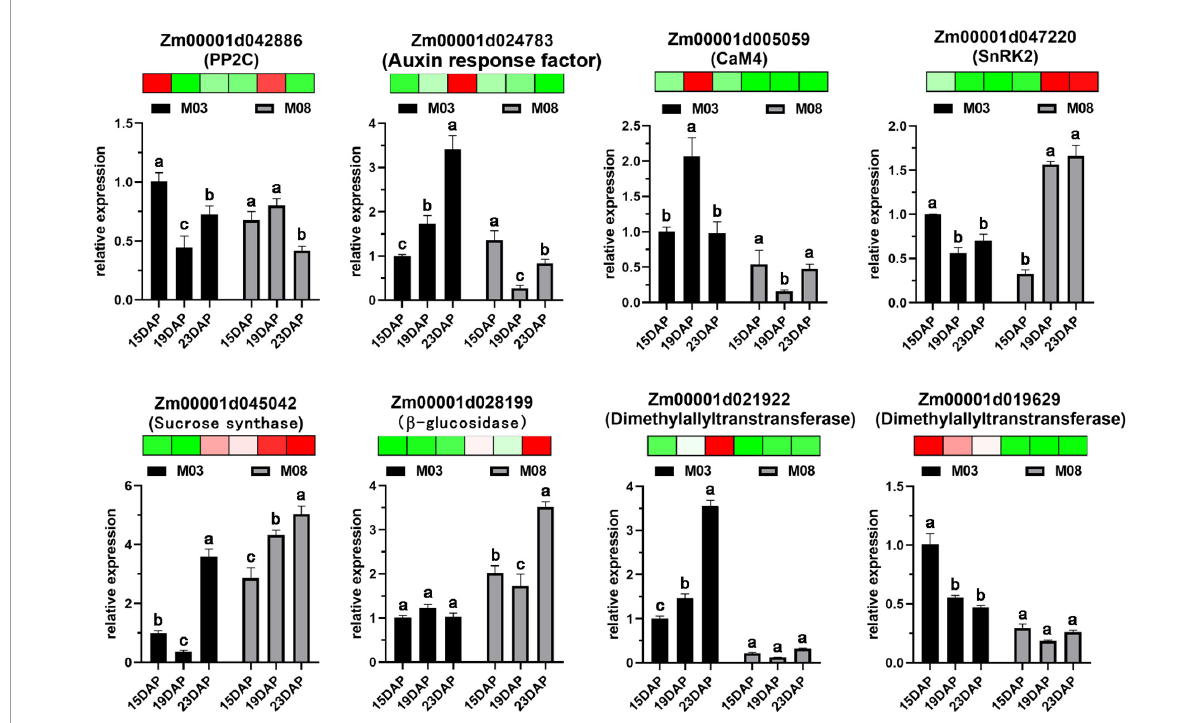
FIGURE8 Validation of eight DEGs using RT-qPCR. Error bars represent the standard deviation of three replicates. Heatmaps were generated using transcriptome data; red indicates high expression levels, and green indicates low expression levels. Lowercase letters above the columns represent statistical differences with the same inbred line ( P <